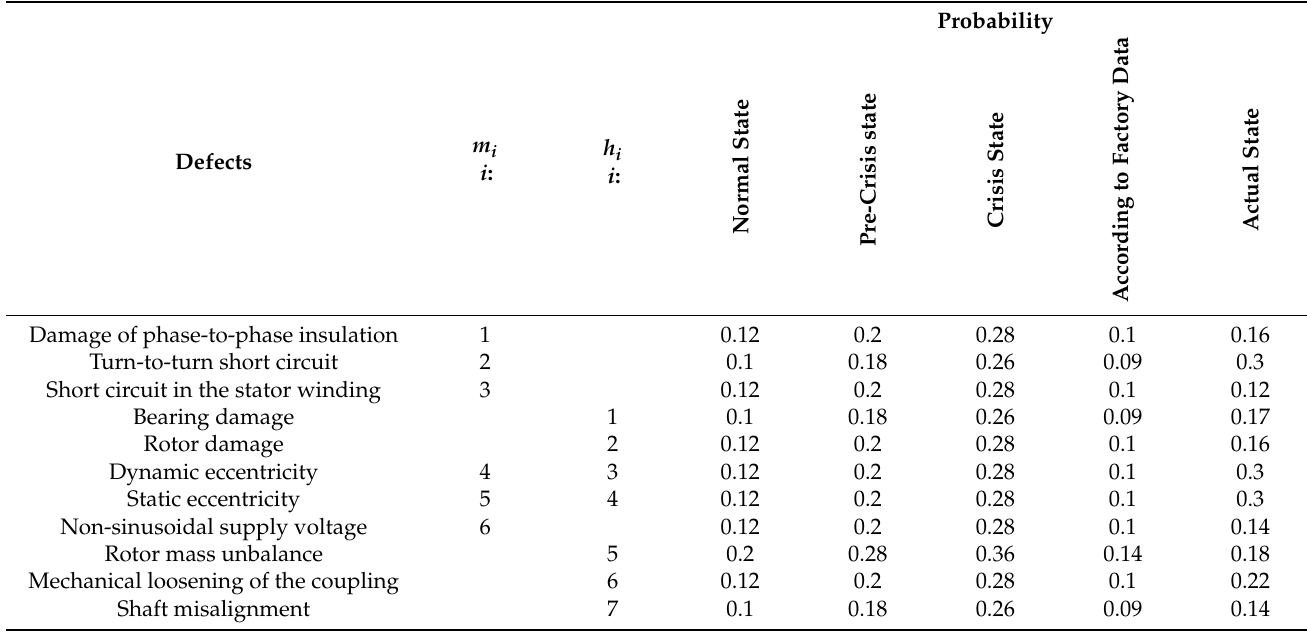
Table 2. Values of defect probability in terms of electrical and vibration parameters at different stages of its operation.